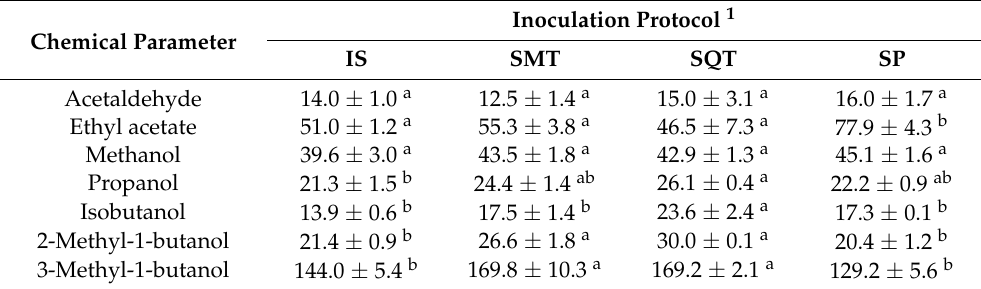
Table 6. Major volatiles (mg/L) of wines produced in in pilot scale fermentations (mean ± SD, n = 2 or n = 3 in IS and SMT). Values not sharing a letter are significantly different ( p < 0.05). Chemical